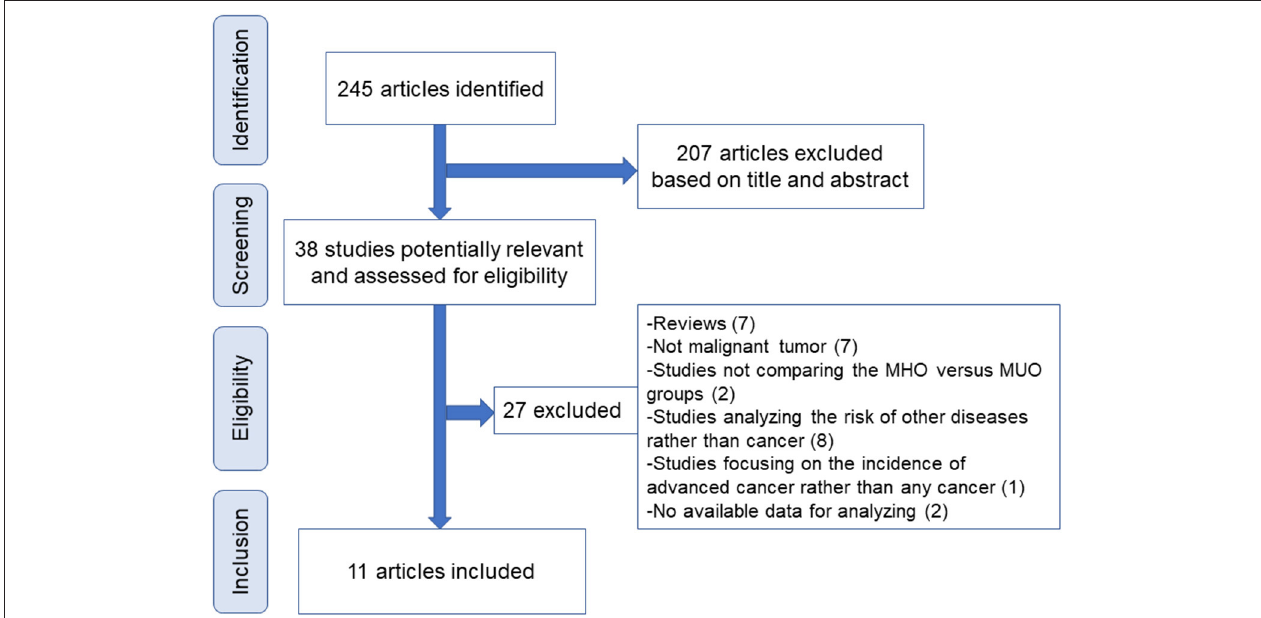
FIGURE 1 | Flowchart of study screening. MHO, metabolically healthy obesity; MUO, metabolically unhealthy